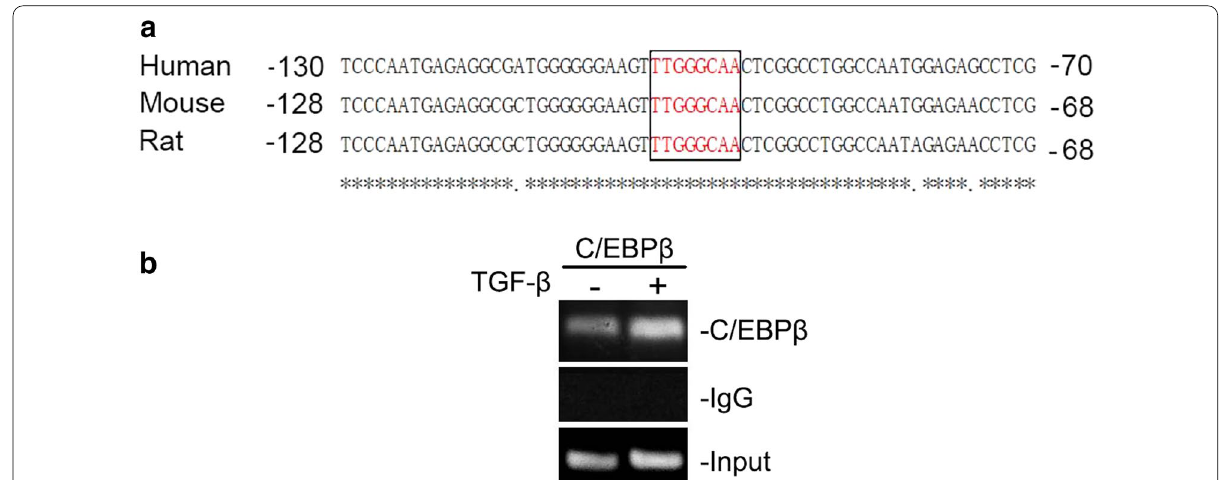
Fig. 4 TGF-β induced C/EBPβ binding to α-SMA promoter in A549 cells. a The 5 ′ promoter sequence of the human, mouse and rat α-SMA gene contains a putative C/EBPβ-binding motif (TTG GGC AA) within 200 bp from the transcription start site. *Indicates conserved sequences. b A549 cells were exposed to TGF-β (10 ng/mL) for 3 h, followed by ChIP assay. ChIP primer pairs, yielding 237-bp PCR products, were designed to amplify DNA corresponding to the C/EBPβ-binding site. A rabbit IgG clone was used as a negative control. Typical traces are representative of two experiments